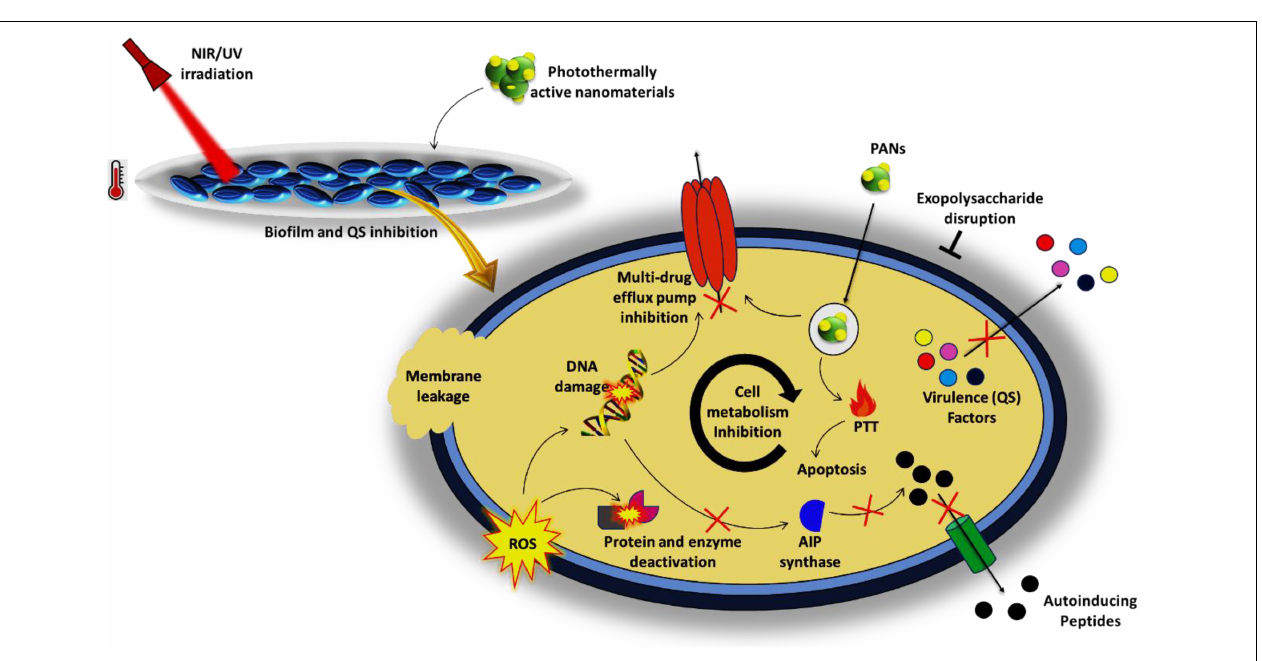
FIGURE 5 | Antibiofilm and quorum-sensing inhibitory potencies of photothermally active